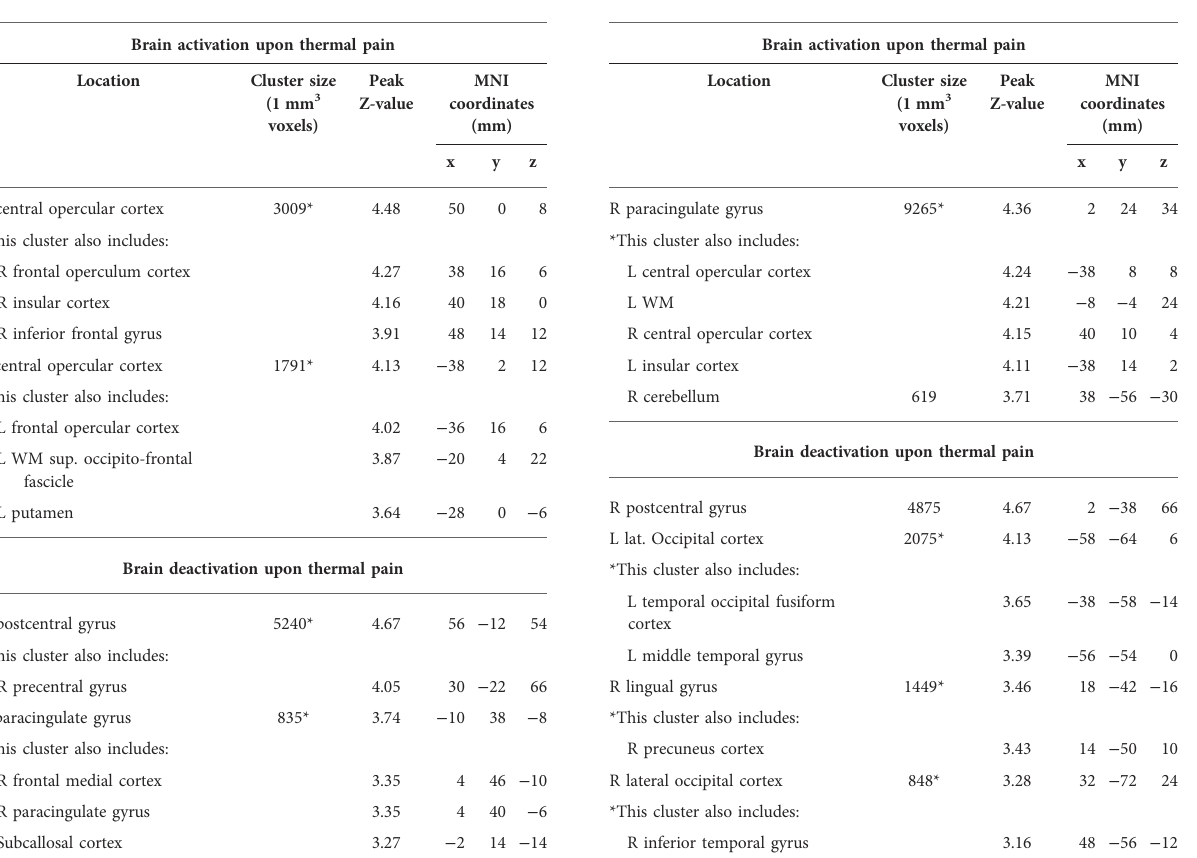
TABLE 4b Brain activation and deactivation post scan spinal